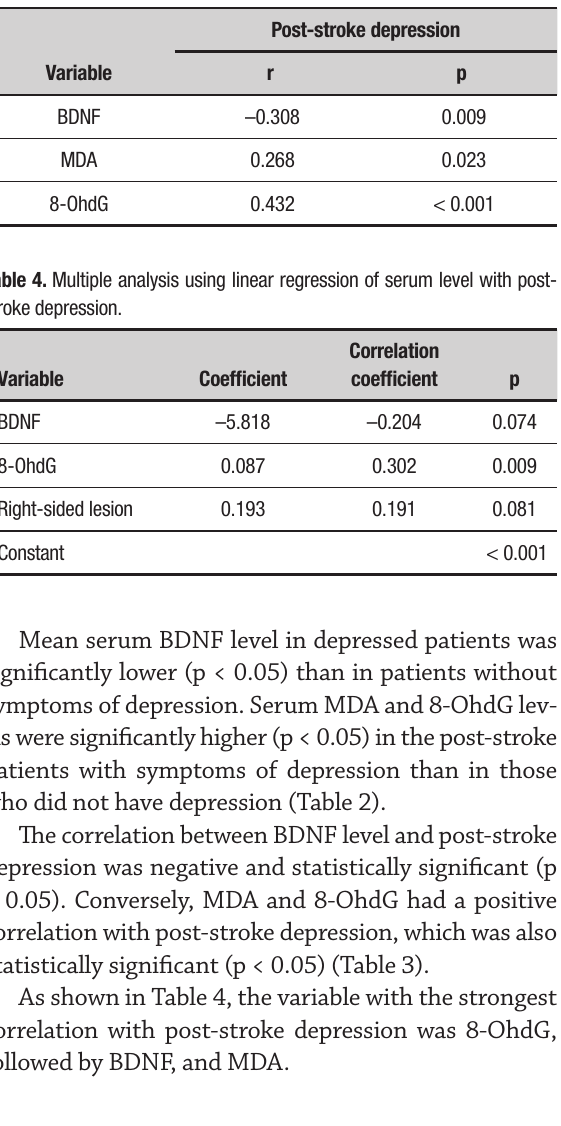
Table 3. Serum BDNF, MDA, and 8-OhdG level correlations with post-stroke depression.